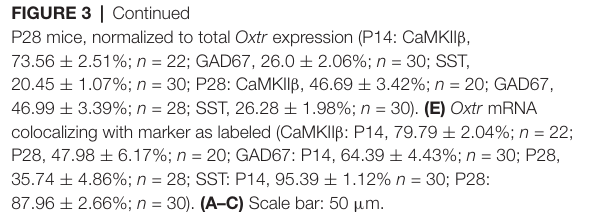
FIGURE 3 | Continued P28 mice, normalized to total Oxtr expression (P14: CaMKII β